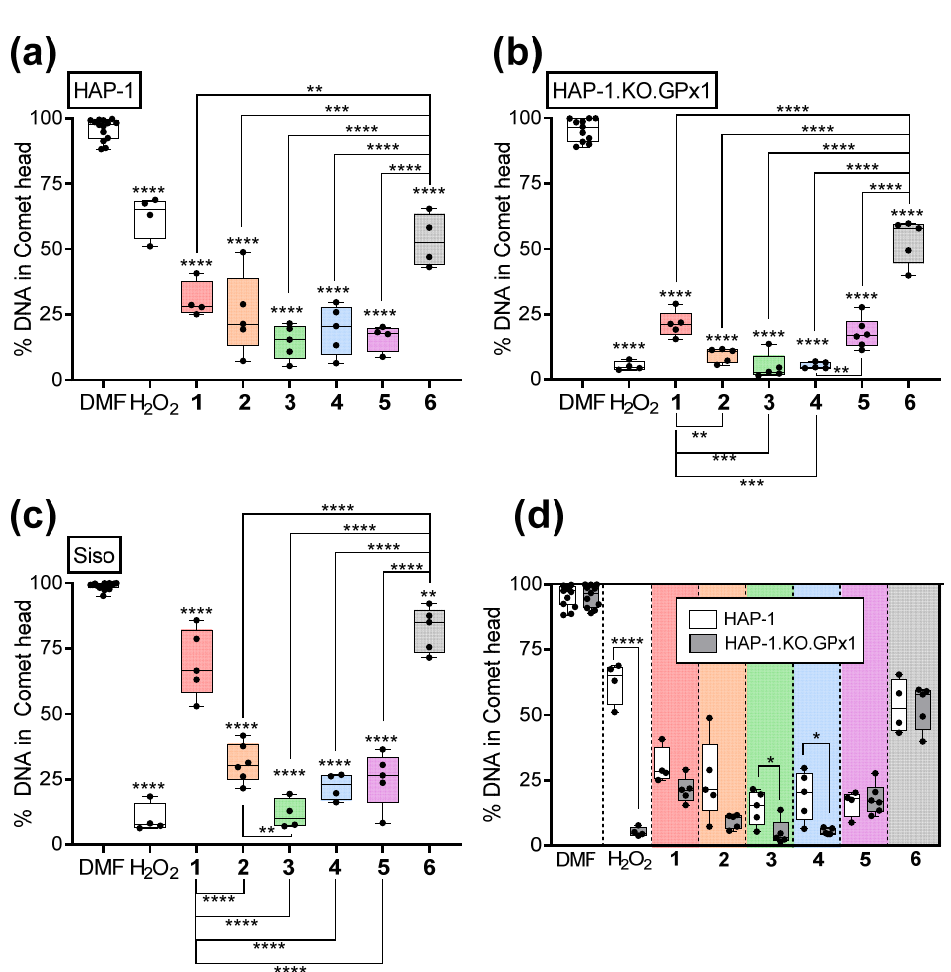
Figure 12. Percentage of intact DNA in the Comet head after treatment of HAP-1 ( a ), HAP-1.KO.GPx1 ( b ), and Siso ( c ) with 25 µ M of pentathiepin 1 – 6 or 20 µ M of H 2 O 2 for 15 min at 0 ◦ C as assessed with the Comet assay. ( d ) A direct comparison of HAP-1 and HAP-1.KO.GPx1 is displayed. Data are presented as box plots with single values, mean and minimum to maximum. Asterisks on boxes indicate difference from solvent control, asterisks on brackets denote inter-compound or inter-cell line variation. Statistical analysis was performed with Prism 7 by one-way ANOVA and Dunnett’s or Tukey’s multiple comparisons post hoc test. n ≥ 4 independent experiments. * p < 0.05, ** p < 0.01, *** p < 0.001, **** p < 0.0001.